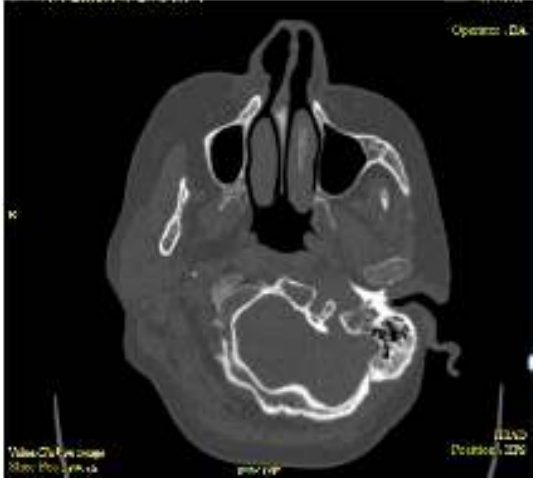
Figure 3. Sinus CT